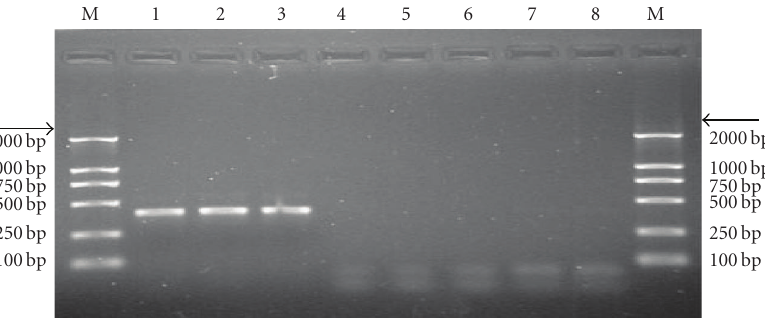
Figure 6: RT-PCR product of HBs gene: M: Markers; 1, 2, and 3: the samples from three single embryos with green fluorescence showing HBs cDNA positive bands, respectively; 4, 5, and 6: the samples from three single embryos without green fluorescence showing negative results for HBs DNA; 7: the negative control ( − RT); 8: the negative control ( −